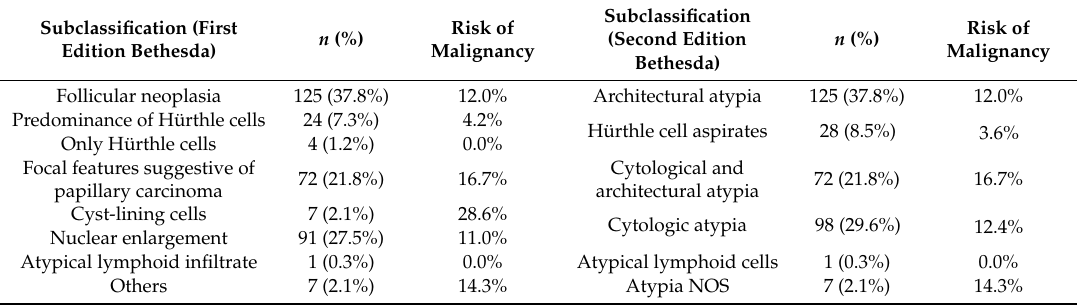
Table 3. Subclassification of AUS / FLUS cases according to the first and second editions of Bethesda and their risk of malignancy. NOS, atypia not otherwise